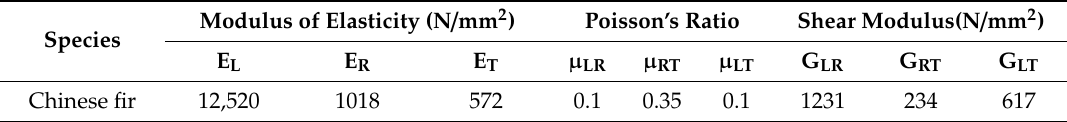
Table 7. The ultimate load values and the corresponding deflection of bending beams.